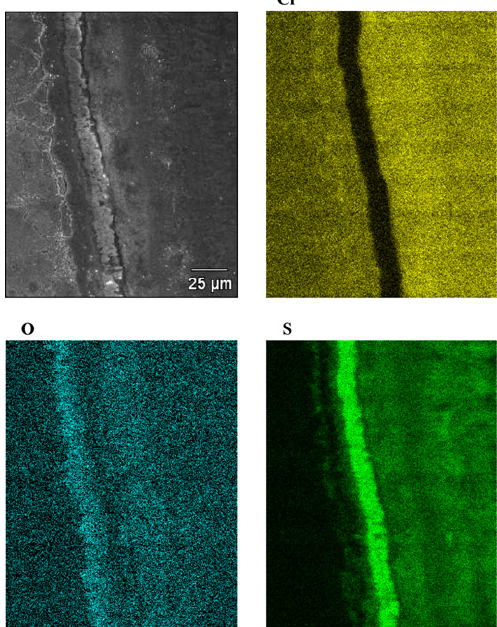
Figure 18: SEM analysis. Map of corrosion crust – 800